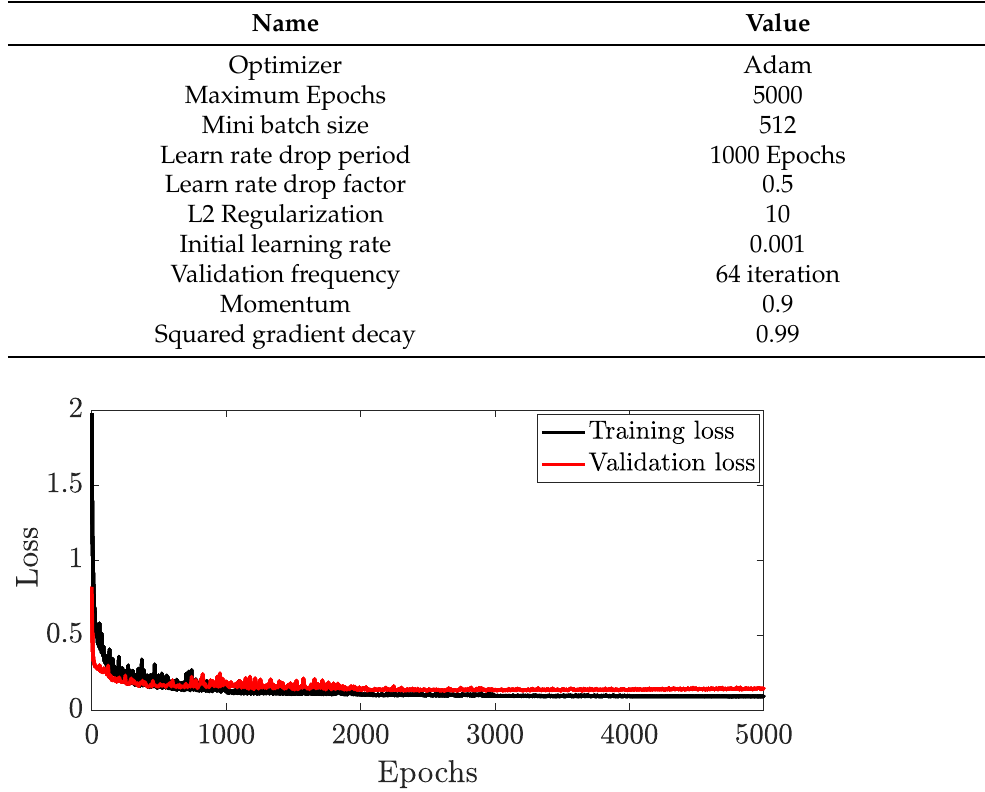
Figure 7. Loss versus epochs (number of passes of the entire training dataset) for the proposed deep neural network